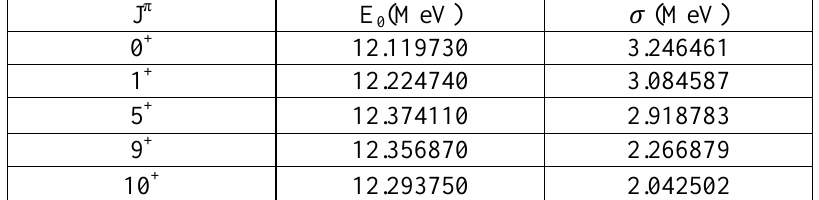
Table 2: Values of E and σ to 68 Ge for various J π = ( 0 + ,1 + , 5 + , 9 + , and 10 + ) states for 12 0 particles move in the f5p-shell model space.